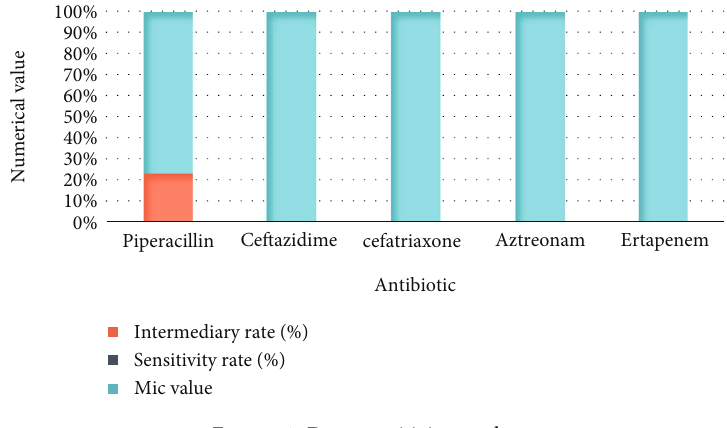
Figure 1: Drug sensitivity results.